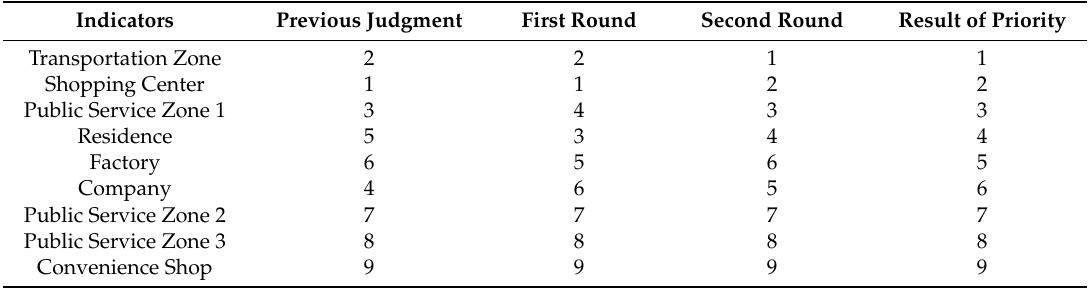
Table 1. The weights of points of interest (POIs): first and second round. Smaller numbers indicate a higher priority with a range from 1 to